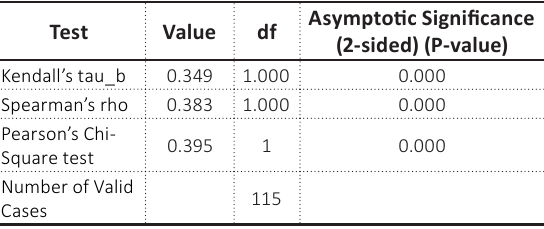
Table 5. Relationship between coaching, mentoring, and employee performance